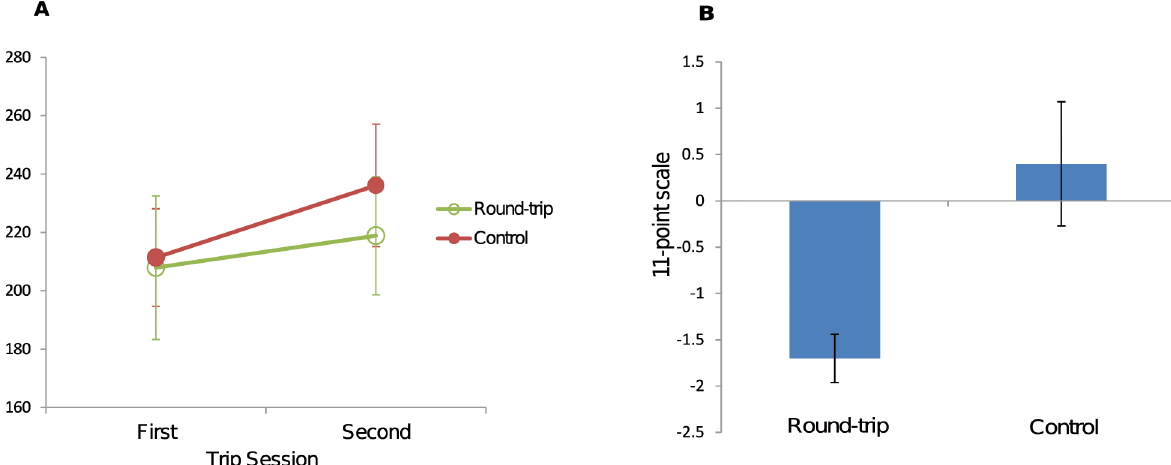
Fig 2. Time estimations. (A) Mean RP3 in each condition, calculated across participants, and (B) mean 11-point scale in each group, calculated across participants. Values are means ± 1SE. RP3, repeated production of a 3 min